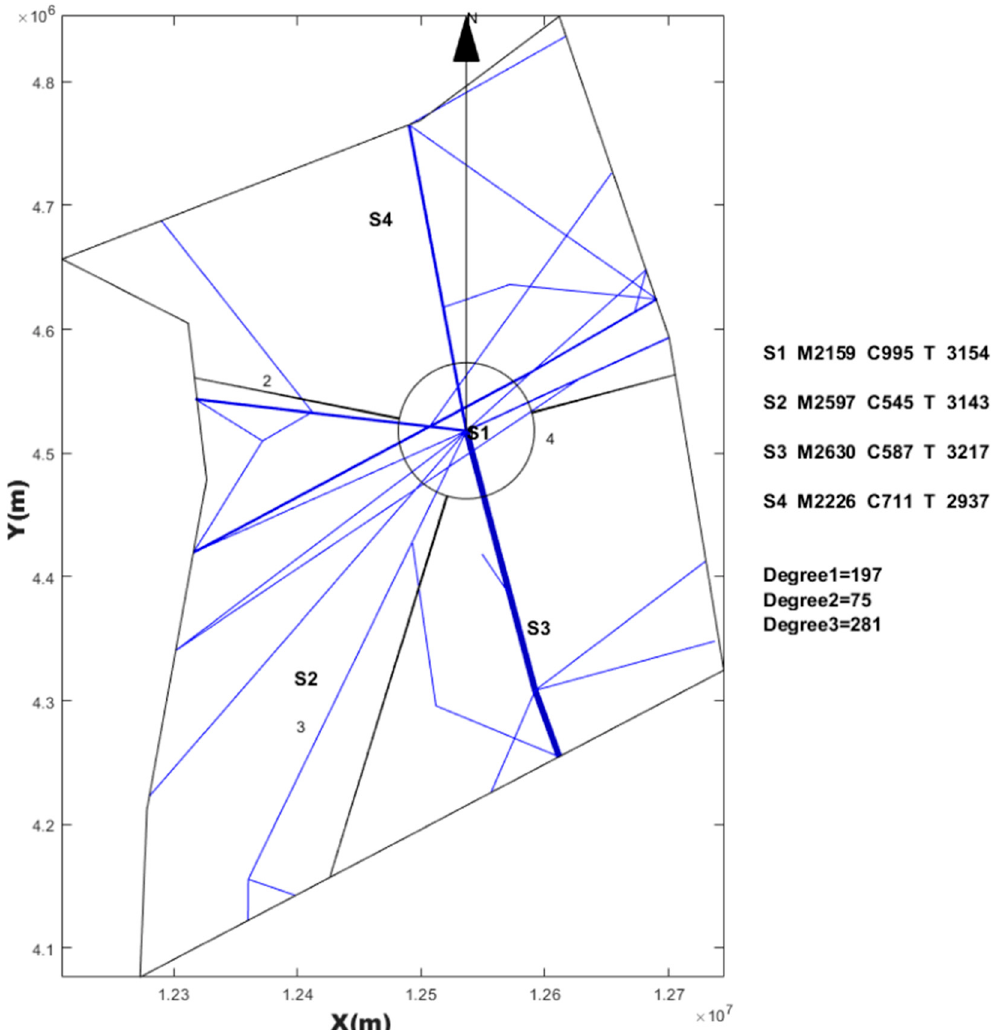
Figure 20. Post-processing results of Figure 16 with MC-RC.